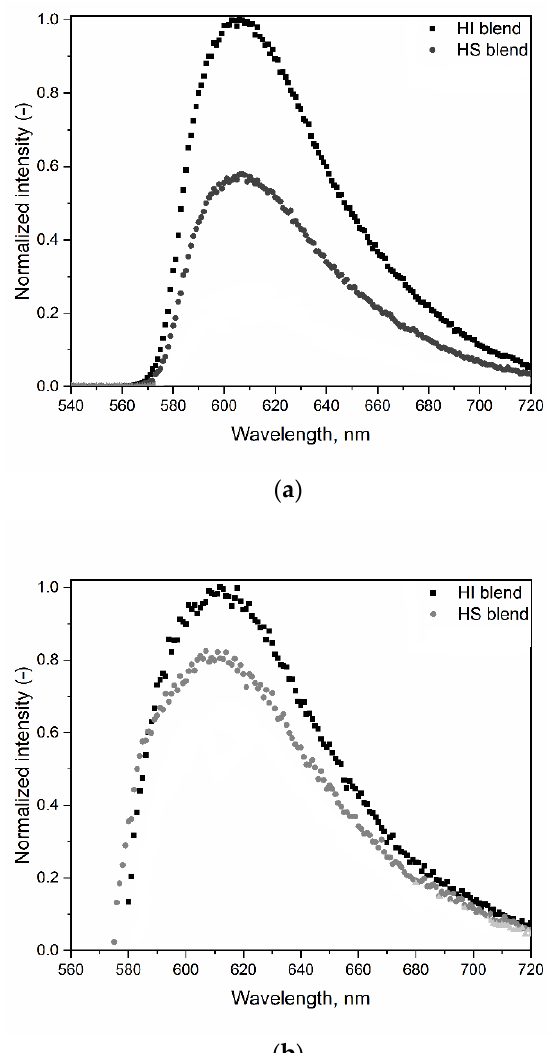
Figure 1. ( a ) Normalized fluorescence emission spectra of 0.1 mM citrus red 2 (CR) in hydrogenated soybean fat + interesterified soybean fat blend (HI, 52.3% solid fat content at room temperature) and hydrogenated soybean fat + sunflower oil blend (HS, 43.8% solid fat content at room temperature) ( b ) Normalized fluorescence emission spectra of 1.2 mM citrus red 2 (CR) in the lipid phase of cracker doughs made from these fats.